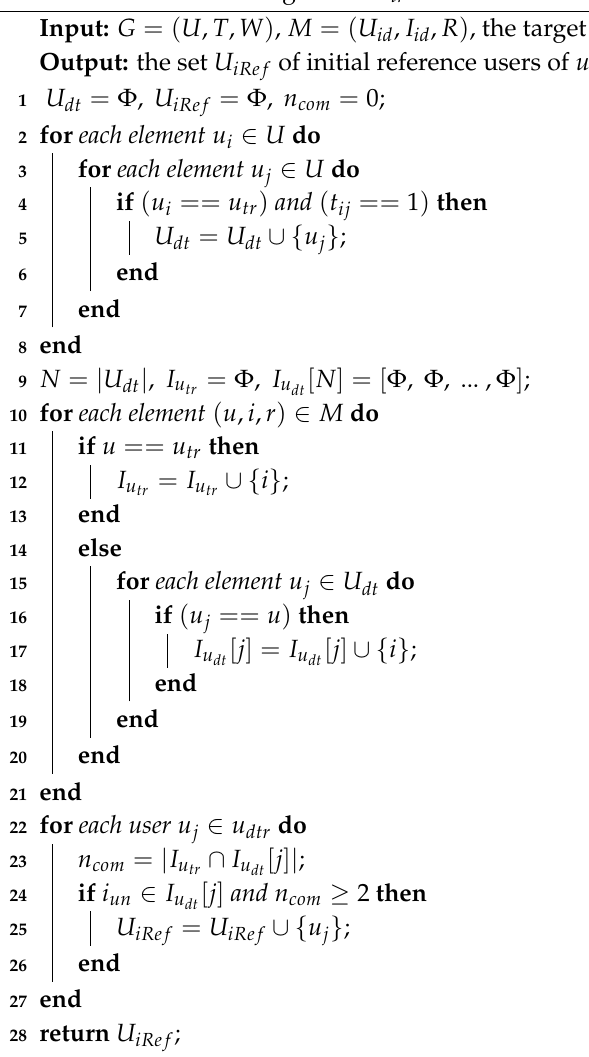
Algorithm 2: Determining the reference users of a target user—Step 1: selecting the initial reference users of the target user u